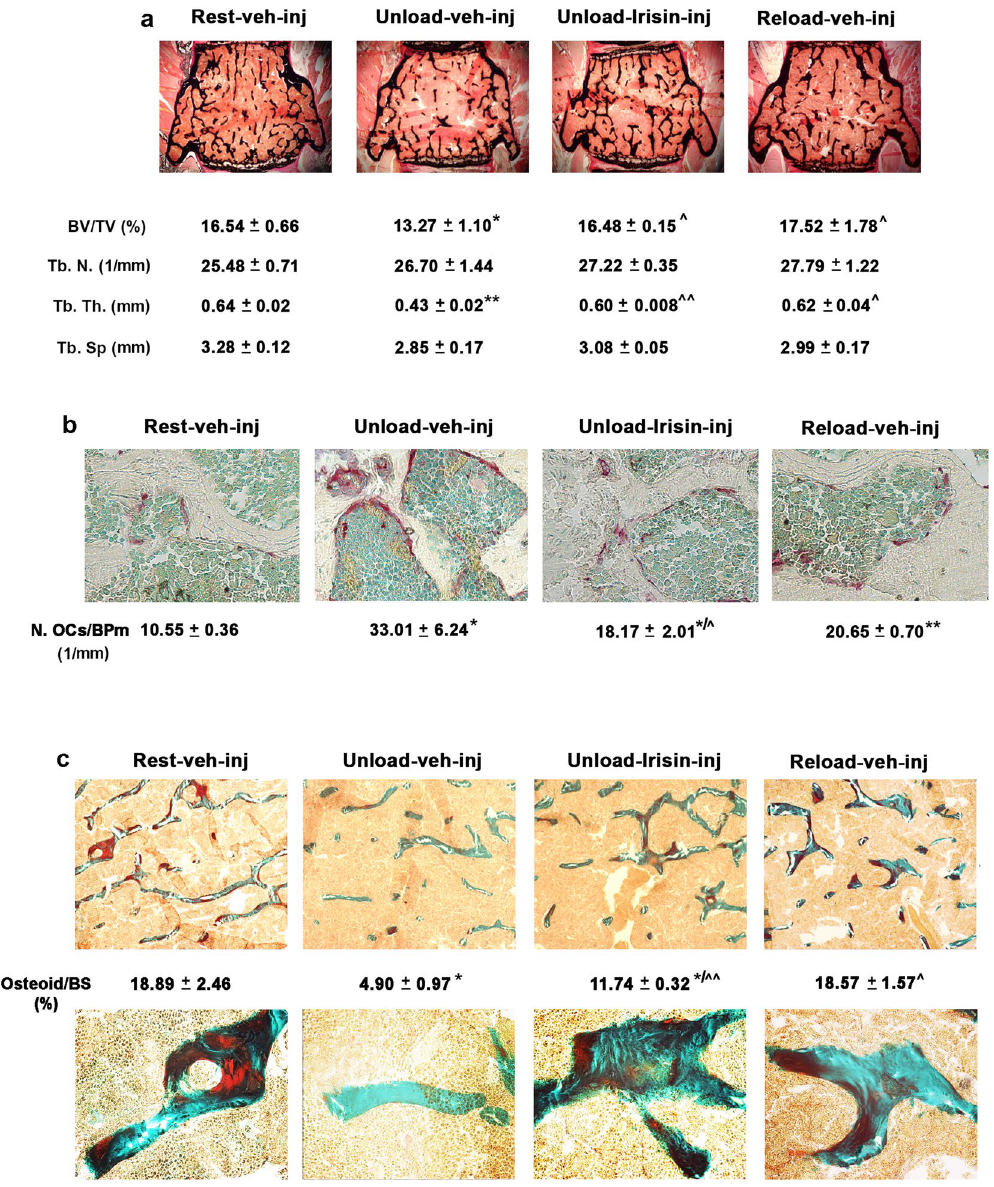
Figure 7. Treatment with r-Irisin recovers bone loss in vertebrae from hindlimb-suspended mice. ( a ) Von Kossa-stained vertebral sections and trabecular bone parameters from normal loading mice (Rest vehicle- inj), unloaded mice treated with vehicle or recombinant Irisin (first r-Irisin injection after 4 weeks of hindlimb suspension, at the dose of 100 µ g kg − 1 per week for 28 days) and reloaded mice (Reload vehicle-inj) (magnification: 2.5x). ( b ) Representative images of tartrate-resistant acid phosphatase-stained osteoclasts in vertebral sections, together with osteoclast counts per bone perimeter (BPm). (magnification: 40x). ( c ) Representative images of Goldner’s Masson Trichrome-stained vertebral sections (magnification: 10x) and photomicrograph of details taken at 40x, together with measurement of percentage of osteoid per bone surface (BS). n = 4–5 mice per group. Data are presented as mean ± SEM. All data were normally distributed according to the Shapiro-Wilk normality test and analyzed by one-way ANOVA and Bonferroni’s post hoc analysis. * p ≤ 0.05, ** p ≤ 0.01 versus Rest vehicle-injected mice. ^ p ≤ 0.05, ^^ p ≤ 0.01 versus Unload vehicle-injected